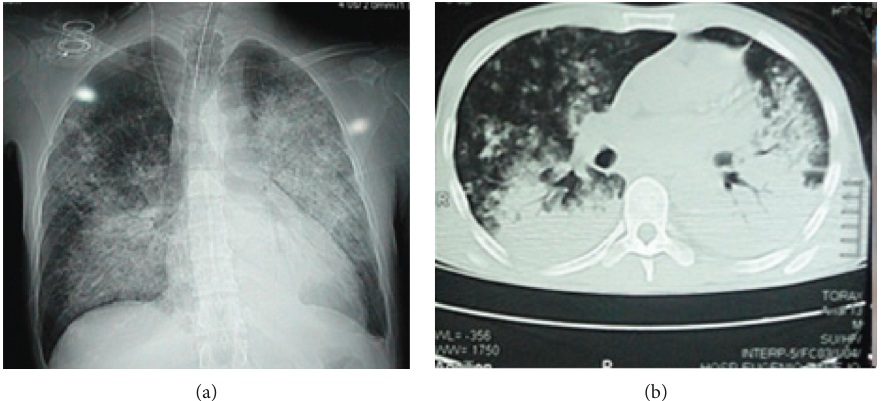
Figure 2: (a) Chest X-ray; AP view: diffuse infiltrate redistributed to the bases; (b) chest CT: diffuse bilateral alveolar